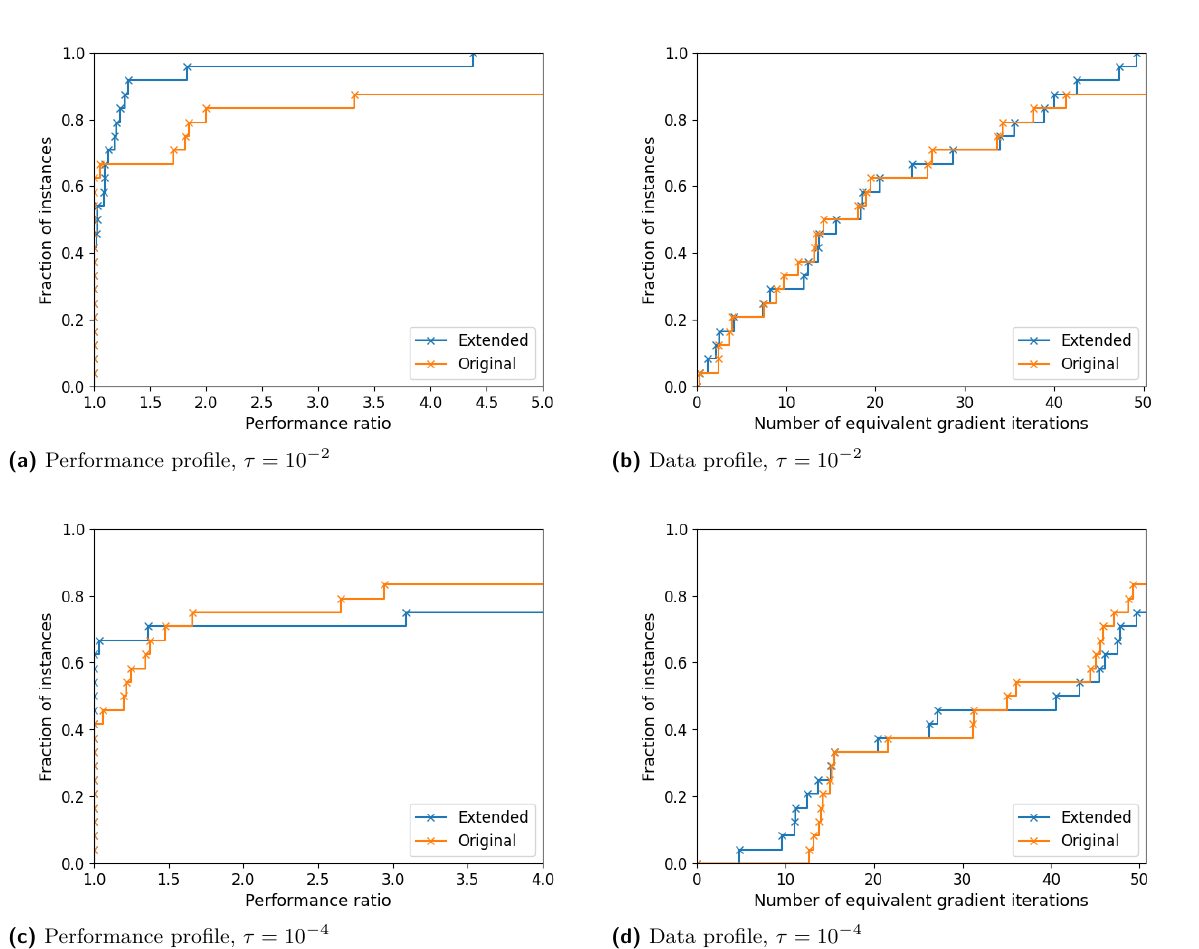
Figure 5 Performance profiles (left) and data profiles (right) for optimization in extended and original